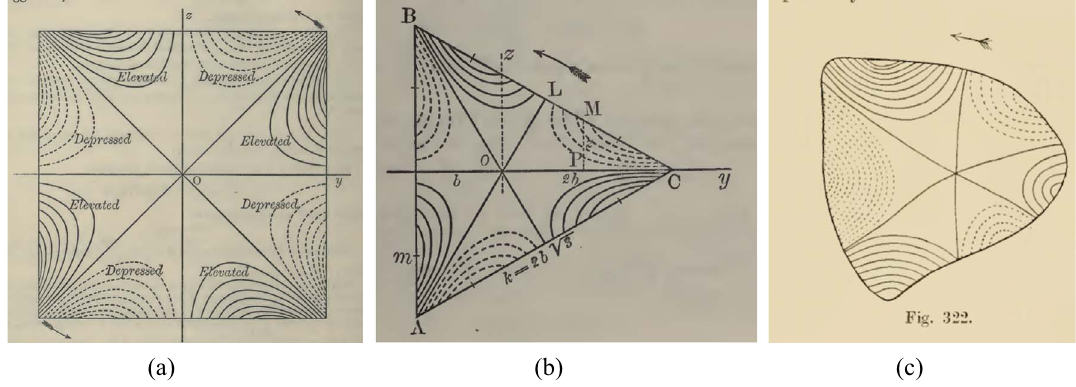
Figure 47. Torsion of prisms with square (a) and triangular (b) cross-sections. Dotted lines are depressed regions and full lines are elevated parts of the cross sections. (c) Anticlastic surfaces in the horns of rams